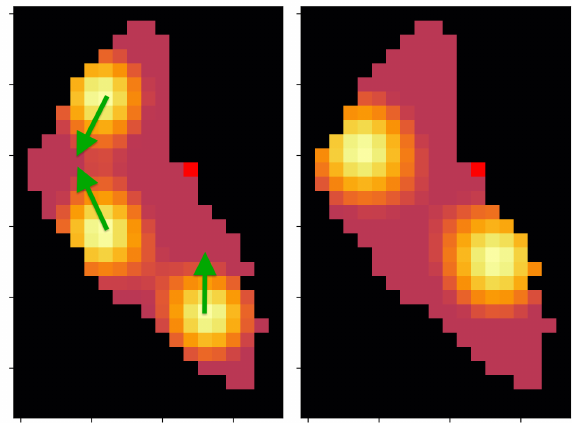
Figure 16. Transformation of the interest map. The green arrows represents the movements of the peaks of